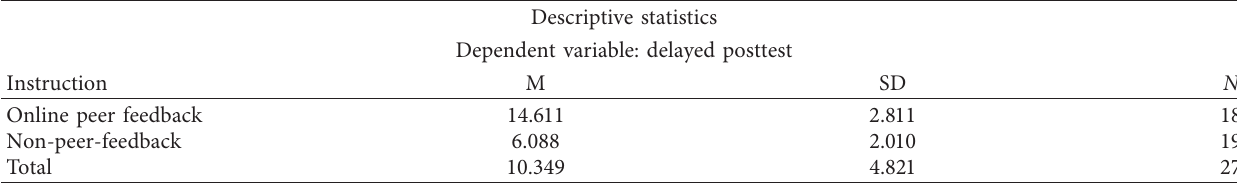
Table 7: Descriptive statistic for comparing the online peer feedback and non-peer-feedback on delayed